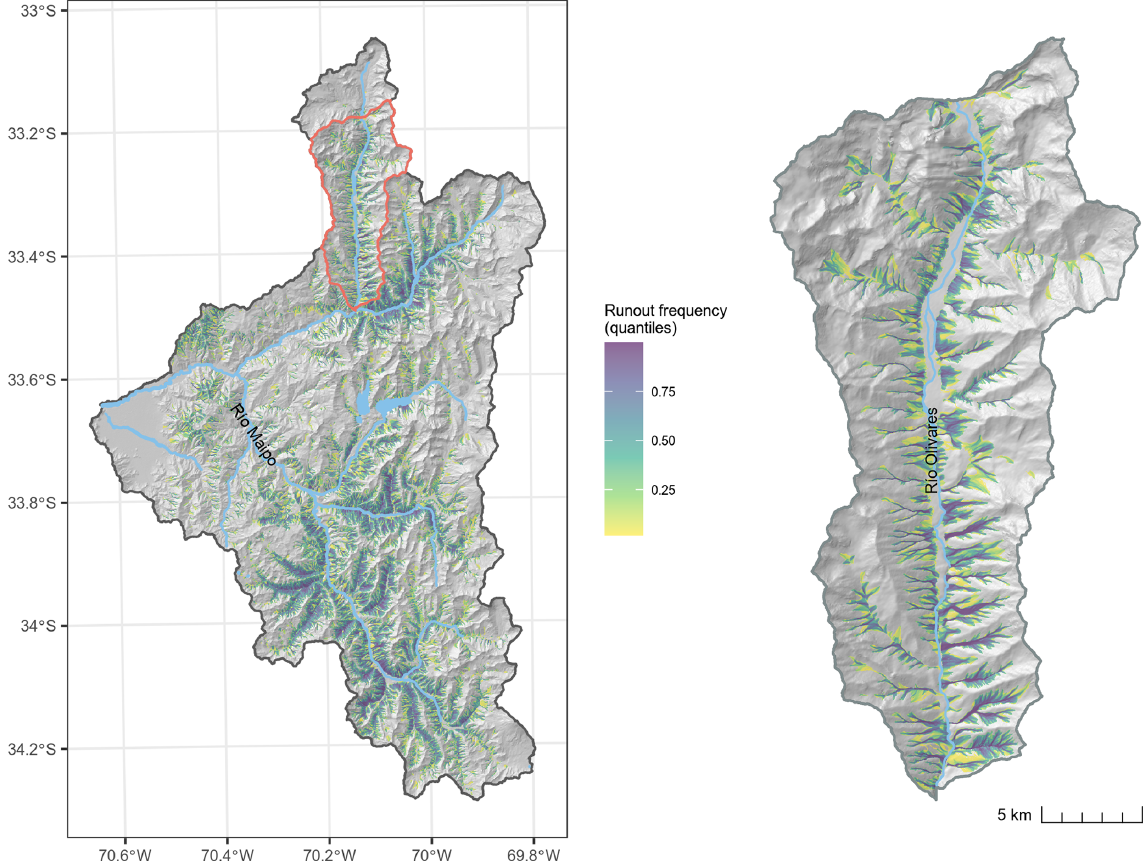
Figure 9. Map of optimized debris-flow runout model based on global parameters and source-area threshold of